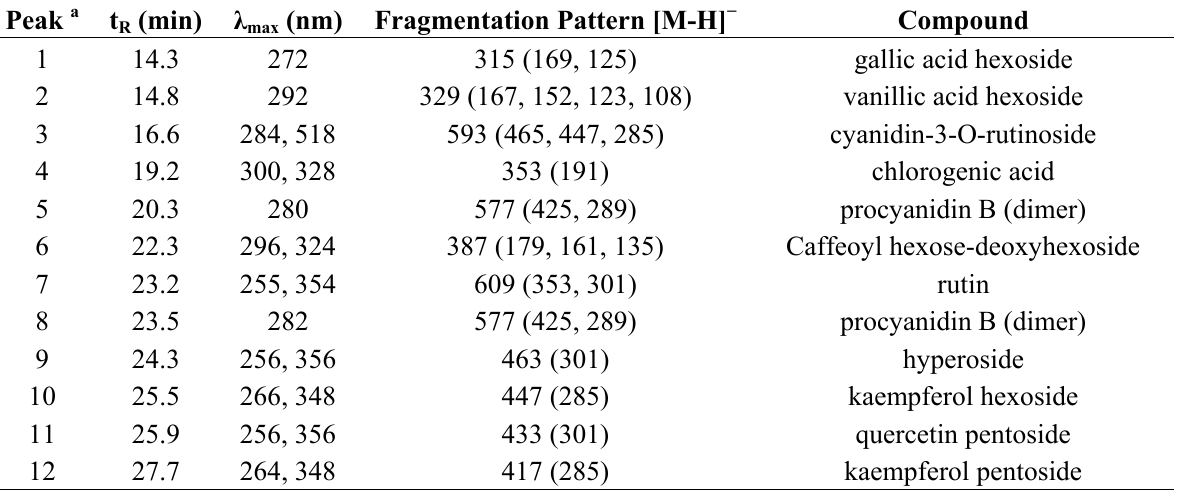
a peak numbers correspond to Figure